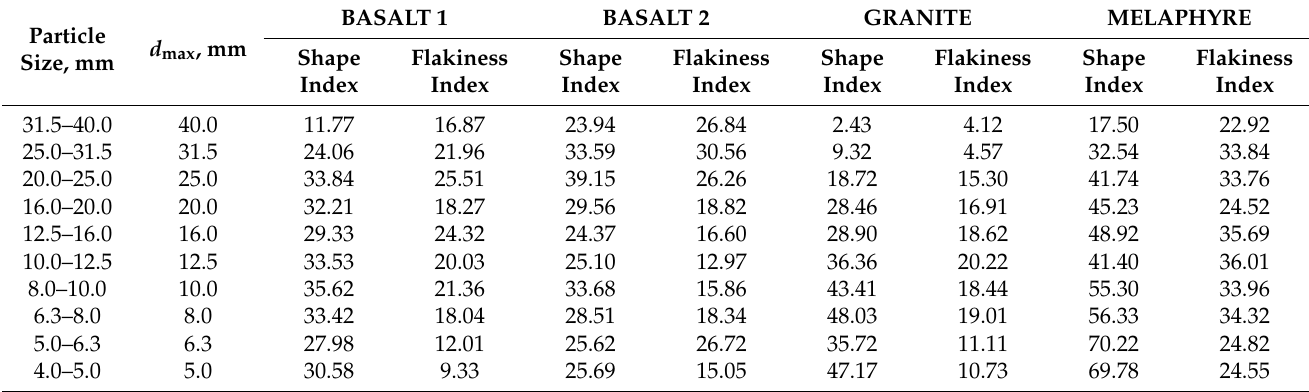
Table 2. Average shape and flakiness indexes for the analyzed igneous